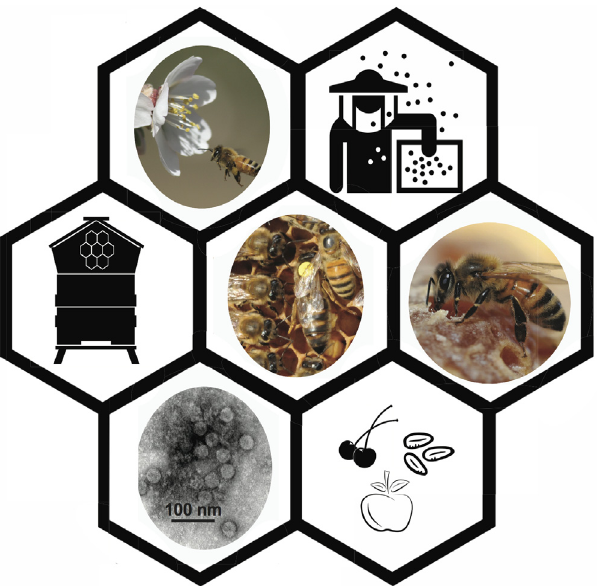
Fig 1. Honey bees are important plant pollinators that are readily infected with RNA viruses. Honey bees ( Apis mellifera ) are eusocial insects that live in large colonies that are composed of sterile female worker bees (~35,000), hundreds of male bees (drones), and a single reproductive female, the queen bee. Beekeepers manage millions of bee colonies for honey production and pollination of numerous fruit, nut, vegetable, and oilseed crops. High losses of bee colonies in North America and some parts of Europe have led researchers to examine the role of multiple stressors, including RNA viruses, on bee health at both the individual and colony levels. Figure photo credits: honey bee and almond flower (middle left) by Christi Heintz, queen bee and attendants (center) and worker bee and honey (middle right) by Kathy K. Garvey, and Lake Sinai virus 2 (LSV2) transmission electron microscope image (lower left) by Sue Brumfield. Noun Project icon credits: bee hive (middle left) by Les vieux garcons, beekeeper (top right) by Luis Prado, and cherry, almonds, and apple by May Irine, Thomas Knopp, and Andrea Bobadilla,